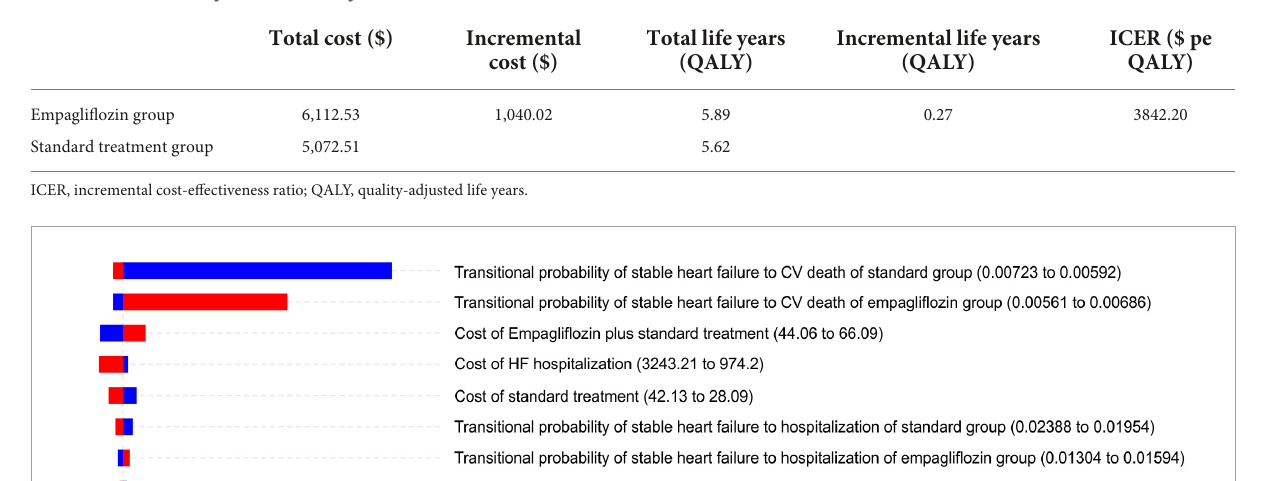
TABLE 2 The results by base-case analysis.